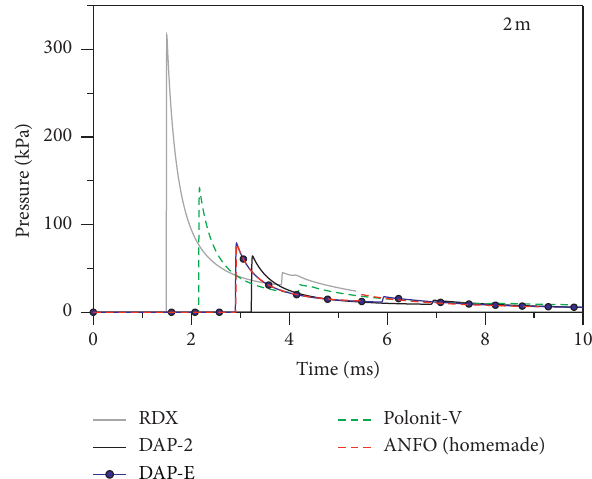
Figure 9: Numerically predicted pressure histories for explosives RDX, DAP-2, DAP-E, Polonit-V, and homemade ANFO (prop- agating through the air in one direction) as measured from gauge #2.